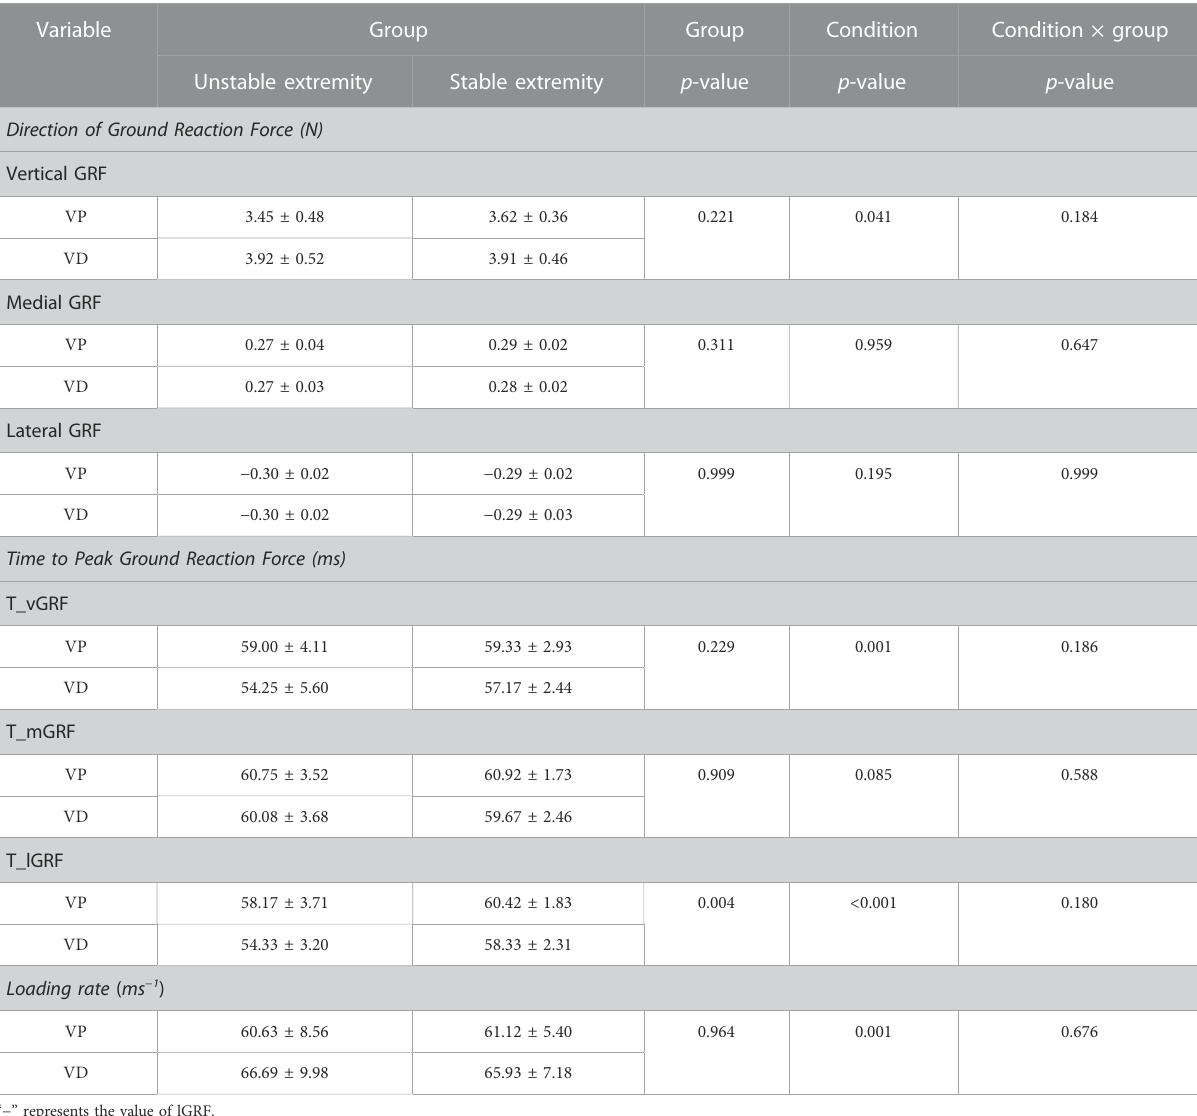
TABLE 2 GRF, T-GRF, and LR of the unstable and stable extremities during landing with and without visual